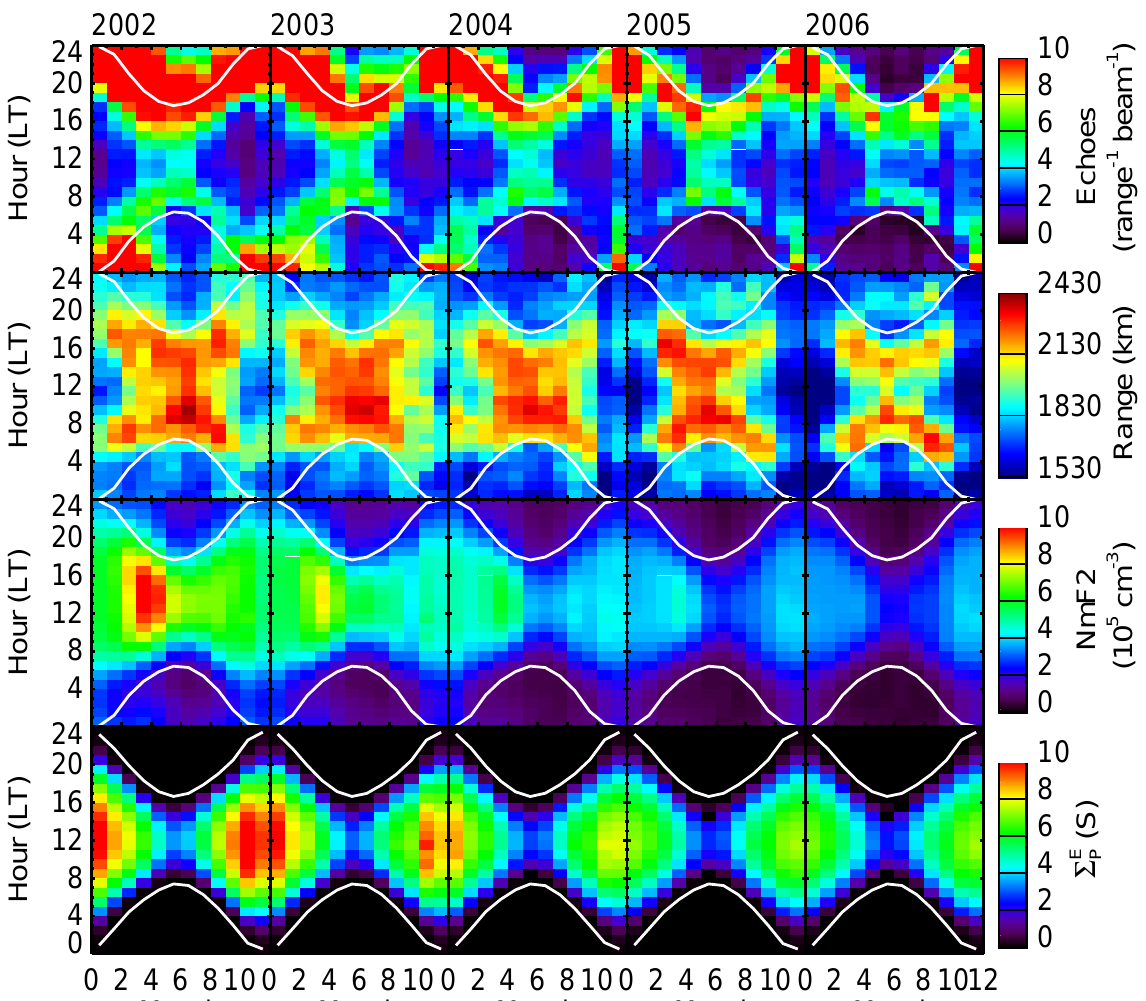
Fig. 3. Quiet-time statistics for the parameters considered in this study. Each column of panels represents one year of data, as indicated at the top of the column. Each row of panels represents one of the parameters. These parameters are from top to bottom: the radar echo occurrence, average slant range of the ionospheric echoes, model Nm F2 and model conductance. The horizontal (vertical) axis of each panel shows the month (local time) of the data shown in each cell. The color code for each parameter is indicated to the right of the figure. The white lines in the 3 top rows (1 bottom row) represent a terminator line at an F-region (E-region) altitude of 300km